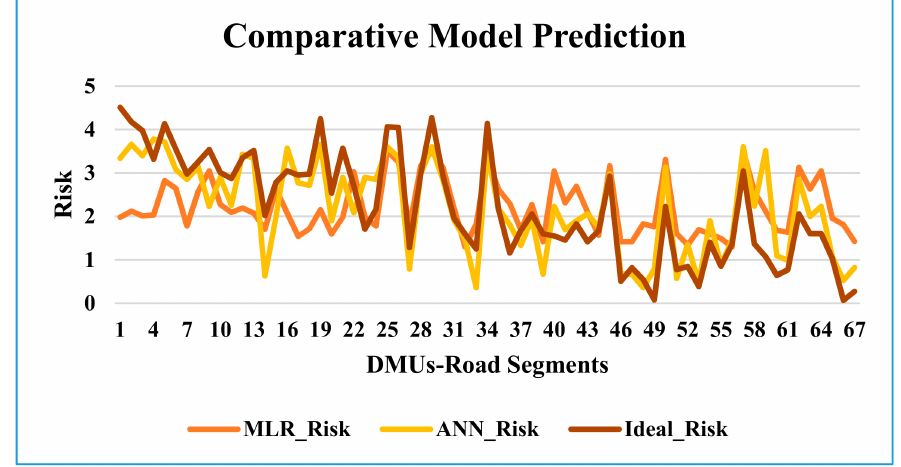
Figure 6. Comparative Analysis for Predicted Vs Actual Risk